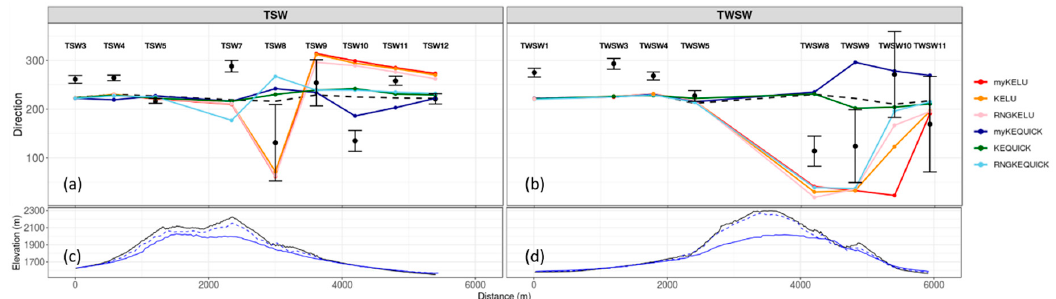
Figure 17. Model comparisons to observed wind directions at Big Southern Butte along transect ( a ) TSW and ( b ) TWSW. DEM and terrain representation in the meshes along transect ( c ) TSW and ( d ) TWSW, as shown in Figure 15b,c. The x-axis in is distance along the transect. Black circles are observed data. Error bars indicate plus and minus one standard deviation. The black dashed lines are the COM solver results.